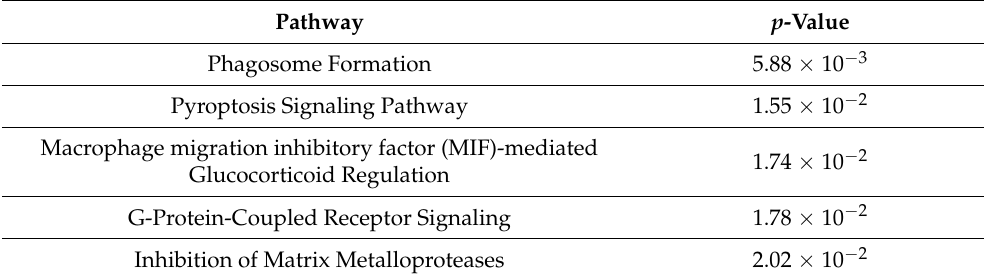
Table 2. Top statistically significant pathways computed using IPA software tool for upregulated